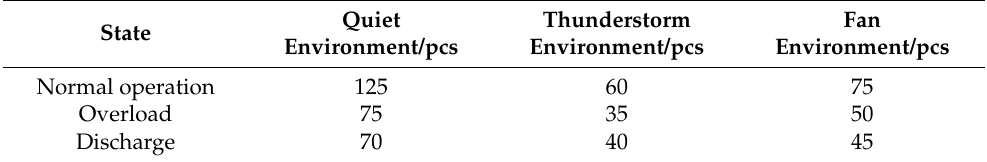
Table 1. Number of sound samples for each condition of 110-kV